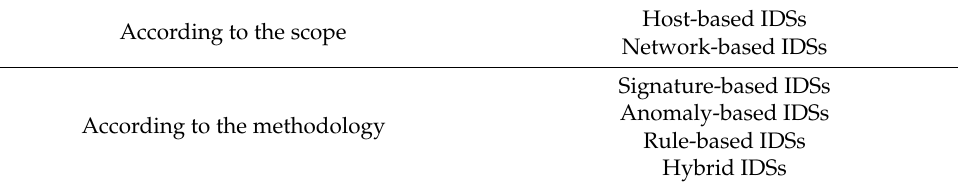
Table 3. Classification of